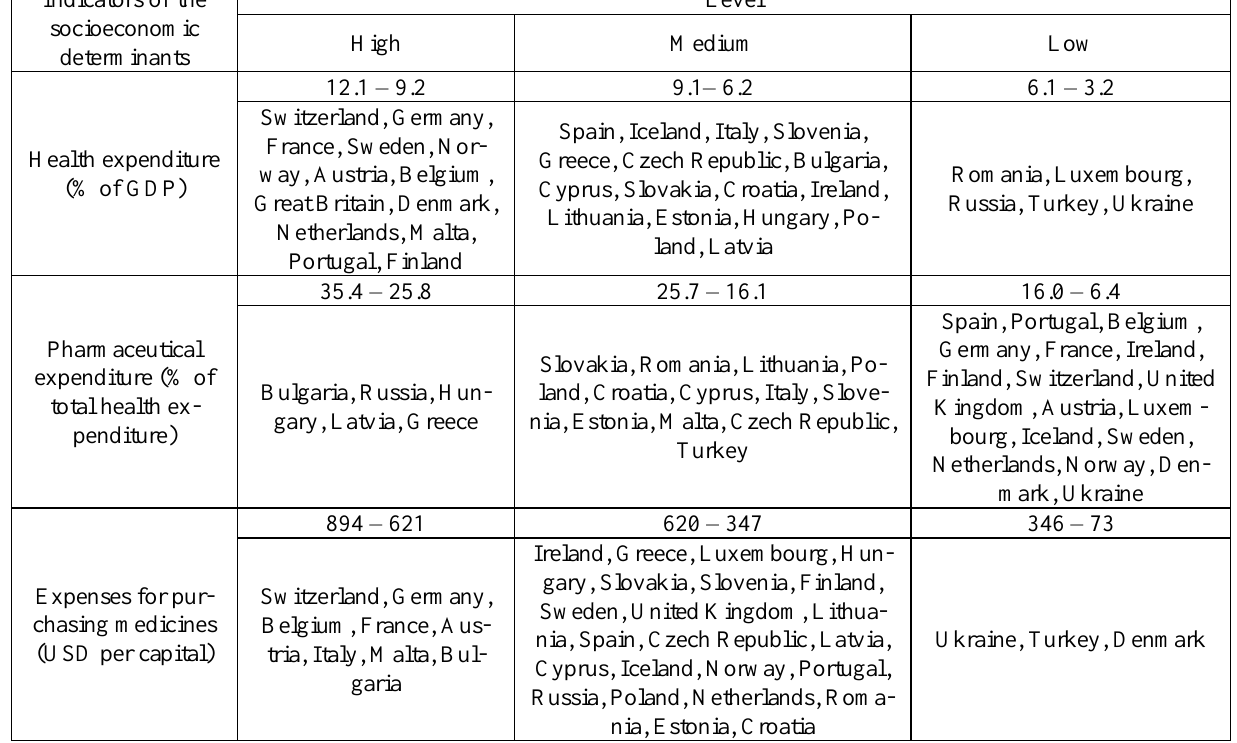
Comparative analysis of key indicators of the socioeconomic determinants of health in countries of the European region Indicators of